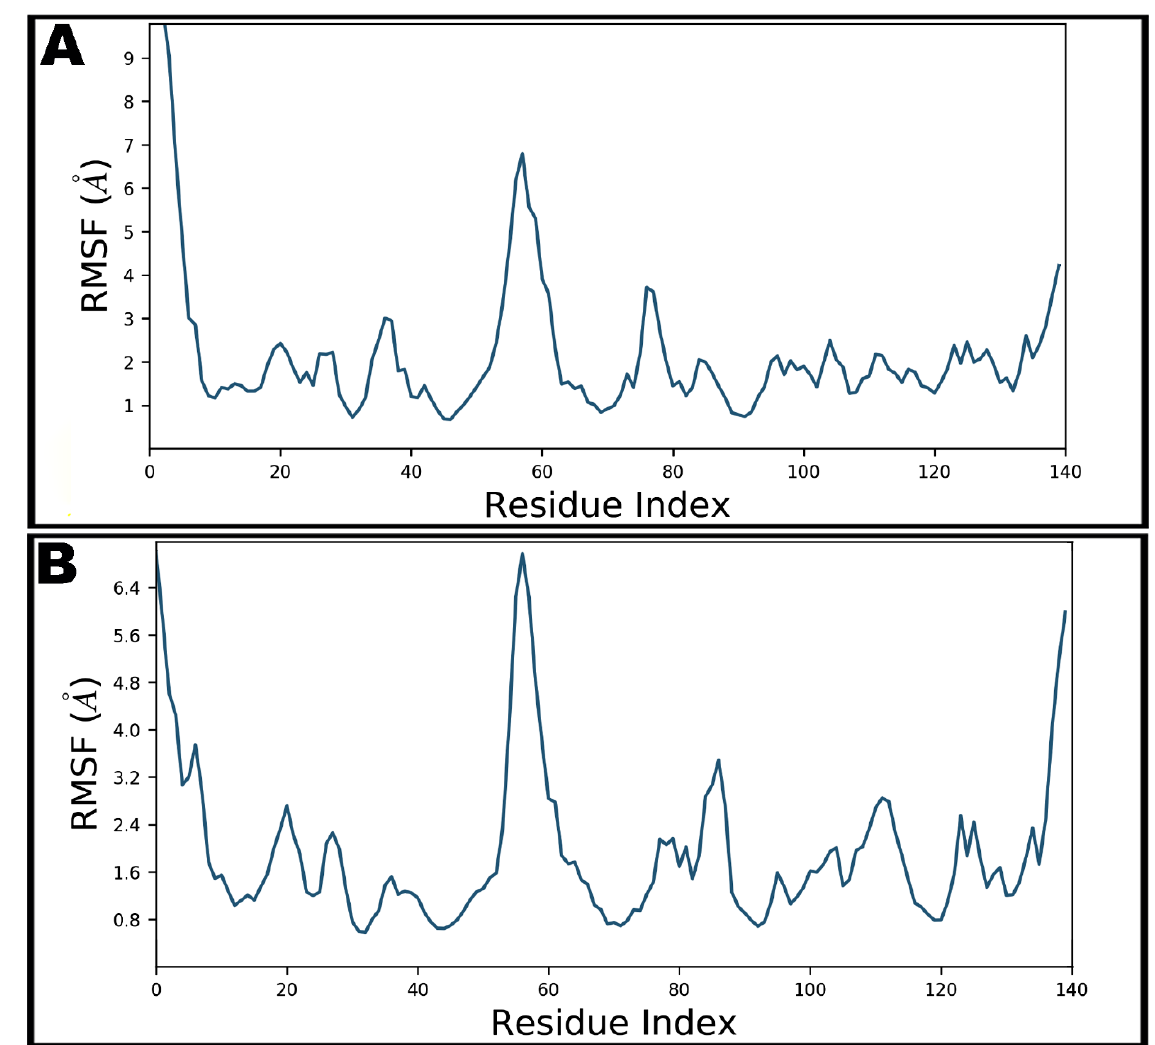
Figure 7. Root-mean-square fluctuations (RMSF) of SARS-CoV-2 nucleocapsid protein N-domain during 100 ns molecular dynamics simulation in apo form ( A ) and teicoplanin bound form ( B ).